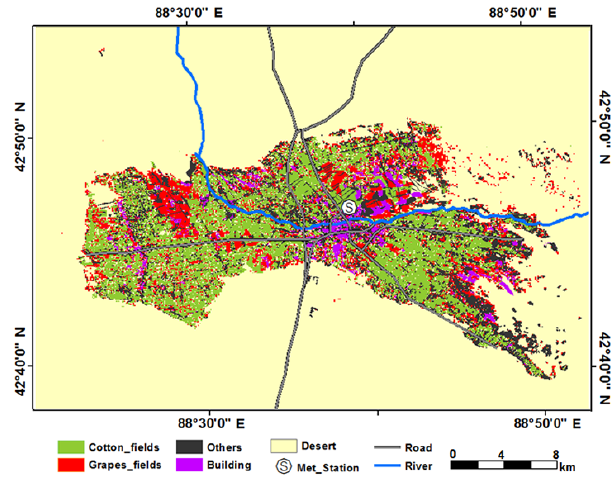
Figure 5. Land cover classification map (2010) derived from a Landsat image (13 August